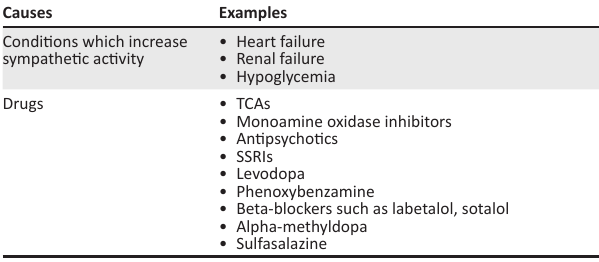
TABLE 2: Conditions or drugs that can lead to false-positive results.